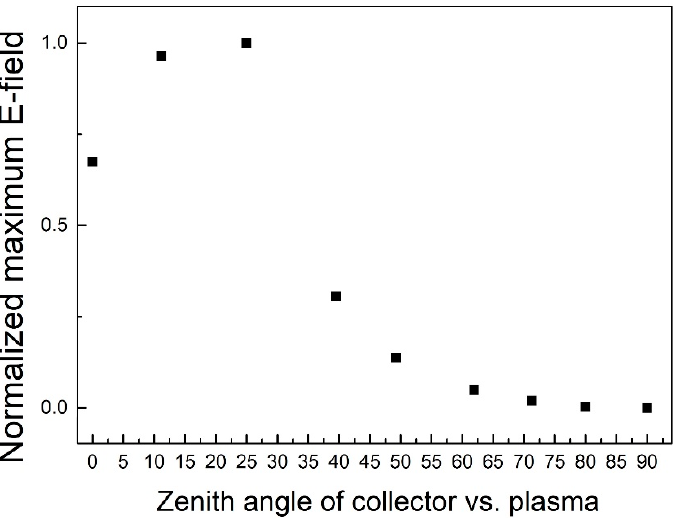
Figure 11. Normalized electric field intensity according to the relative positions of the plasma and detector calculated in the simulation.